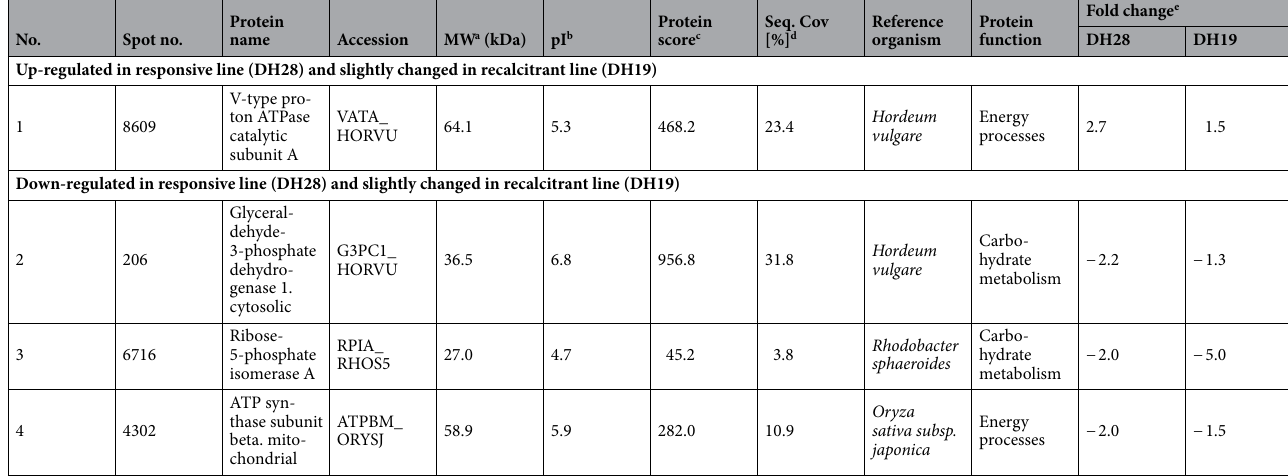
Table 2. A list of anther proteins, which accumulation significantly changed after microspore embryogenesis (ME) inducing triticale tillers treatment combining low temperature (3 weeks at 4 °C) with the application of 10 µM of 5-azacytidine, DNA demethylating agent. Two DH lines of triticale differ significantly in ME responsiveness (highly recalcitrant DH19 and responsive DH28). Swiss-Prot database was used for protein identification. The results are based on nano LC–MS/MS analyses. a The theoretical molecular weight (MW. kDa) and b isoelectric point (pI) retrieved from the protein database. c The score and d protein sequence coverage (Score in Flex Analysis software). e Change in abundance was calculated by dividing the mean %vol of a spot in anthers isolated form low temperature treated tillers (3 weeks at 4 °C) to mean %vol of that spot in anthers isolated from AC treated tillers (10